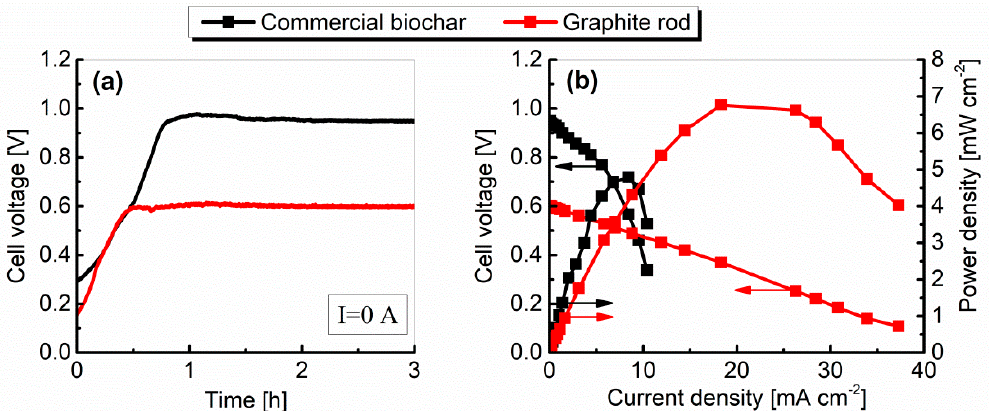
Figure 16. The variation of the fuel cell voltage vs. time ( a ) and performance characteristics ( b ) of MH-DCFC Model II constructed from austenitic stainless steel 300 series.